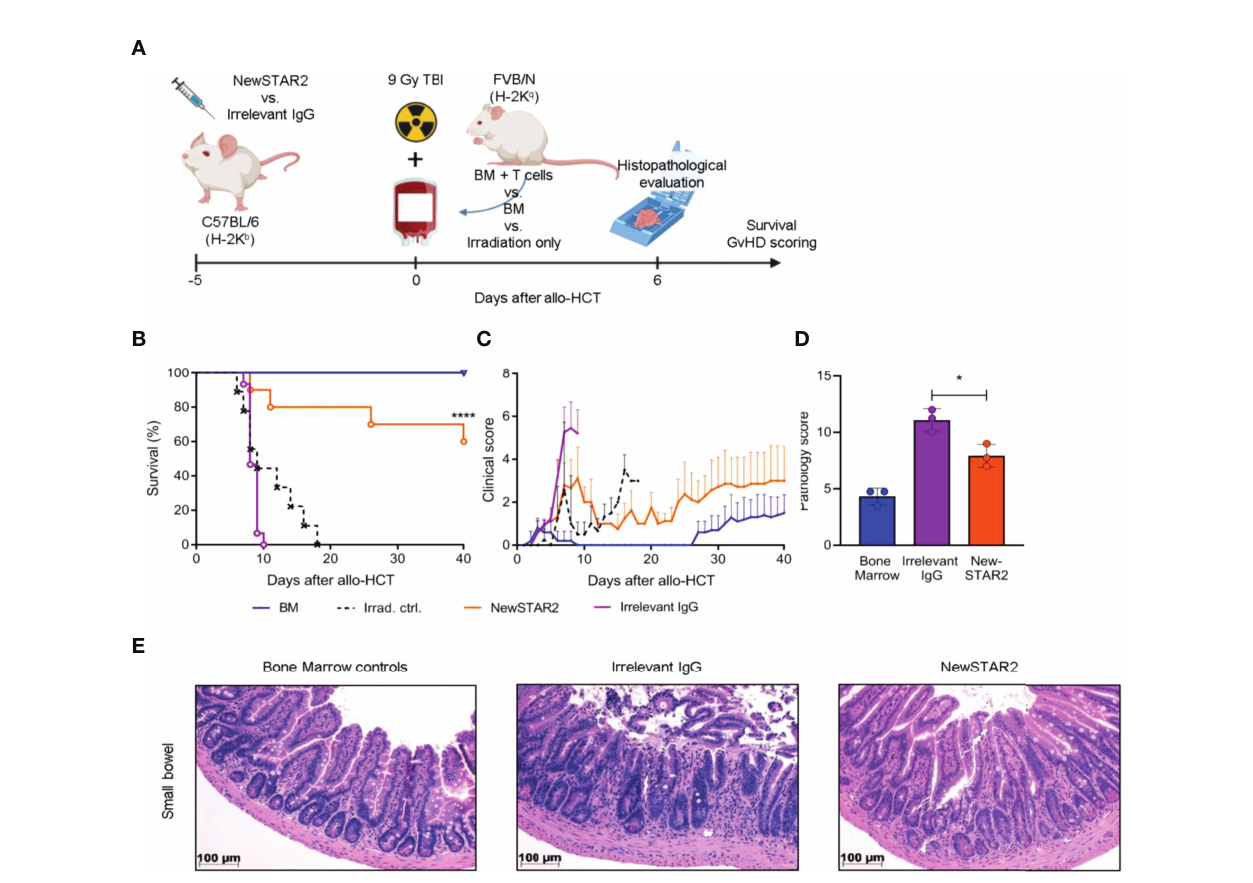
FIGURE 5 | Preemptive Treg expansion with NewSTAR2 protects mice from acute GvHD. (A) Experimental procedure of allo-HCT. C57BL/6 or albino C57BL/6J-Tyr c- 2J /J wild type female mice were injected i.p. with 140 µg of NewSTAR2 or control Irrelevant IgG1 in PBS 5 days before transplantation. 5x10 6 bone marrow (BM) cells from female FVB/N mice plus 6x10 5 splenic T cells from either FVB/N or FVB. Luci + female mice were i.v. injected in each myeloablatively irradiated (9 Gy) B6 recipient. Bone marrow control mice were injected only with 5x10 6 BM cells. Mice for survival experiments were weighed and scored daily for 40 days after allo-HCT. Irradiation control n=9; Bone marrow control n=10; Irrelevant IgG1 control n=15; NewSTAR2 n=10. (B) Kaplan-Meier survival graphs. ****p ≤ 0.0001. (C) Clinical score of mice. (D) Histopathological score at day +6 after allo-HCT. *p ≤ 0.05. (E) Representative hematoxylin and eosin stainings of the small bowel at day +6 after